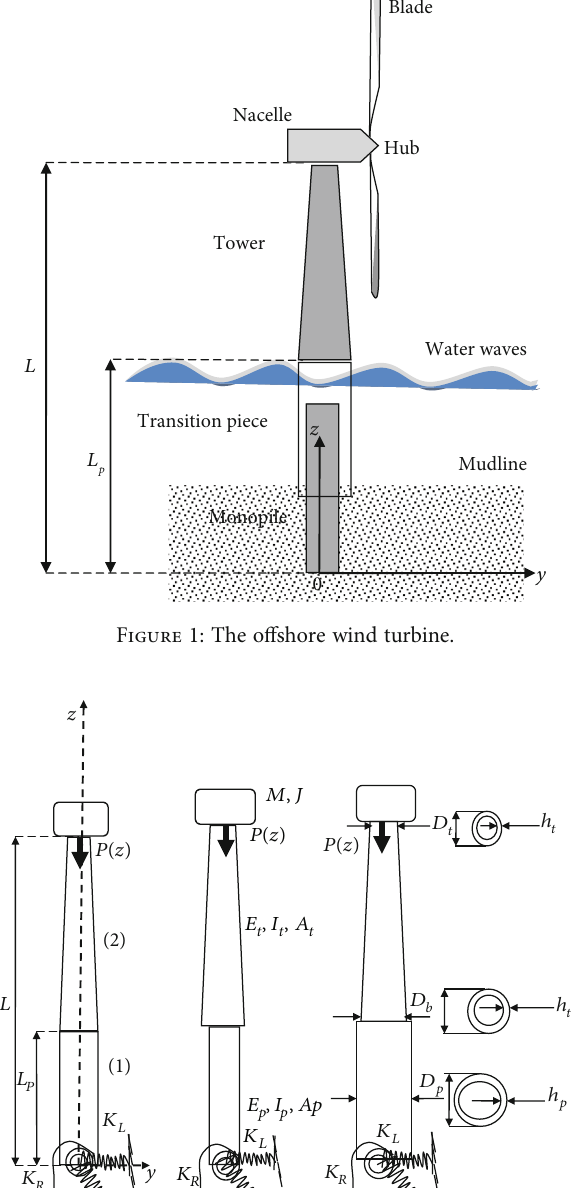
Figure 2: Mathematical model of the OWT. (a) D < D > D . (c) D b p b